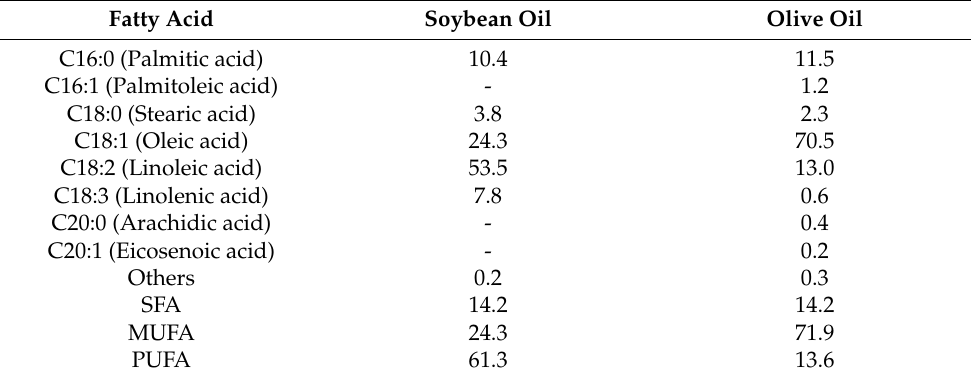
Table 2. The fatty acid composition of the dietary fats in experimental diets (%). Fatty Acid Soybean